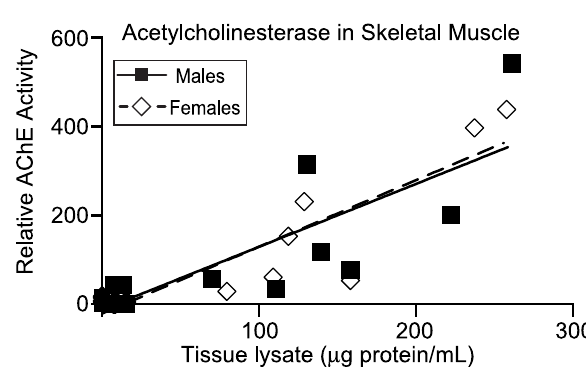
Fig 5. Gender-based analysis of AChE activity. A and B , fluorometric AChE activity assays with liver and skeletal muscle tissue lysates, respectively, from young adult mice (aged 1.5 – 3 months). For both males and females, data points are the combination of four individuals. AChE activities of tissue lysates are reported relative to the activity of an AChE standard supplied with the assay